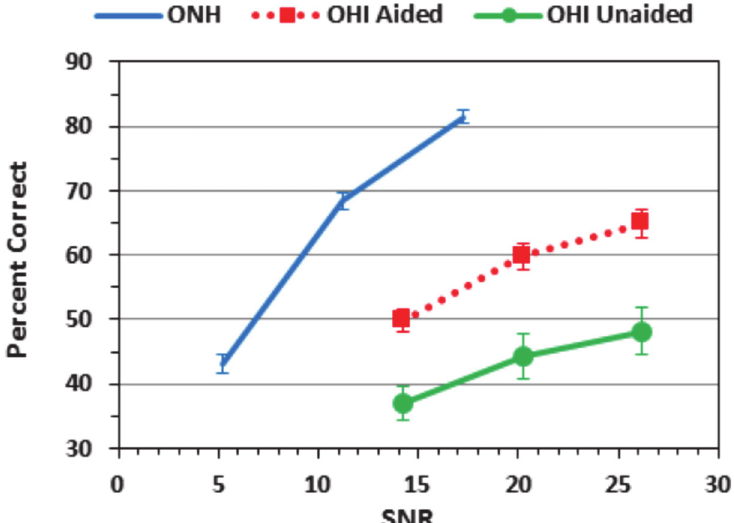
Fig 2. Percent correct scores for the ONH listeners (gray) and for aided (red) and unaided OHI (green) listeners averaged over all consonants in onset and coda positions. The horizontal positions of the curves were determined by the mean levels of SNRs for ONH and OHI listener groups. Error bars show standard errors.